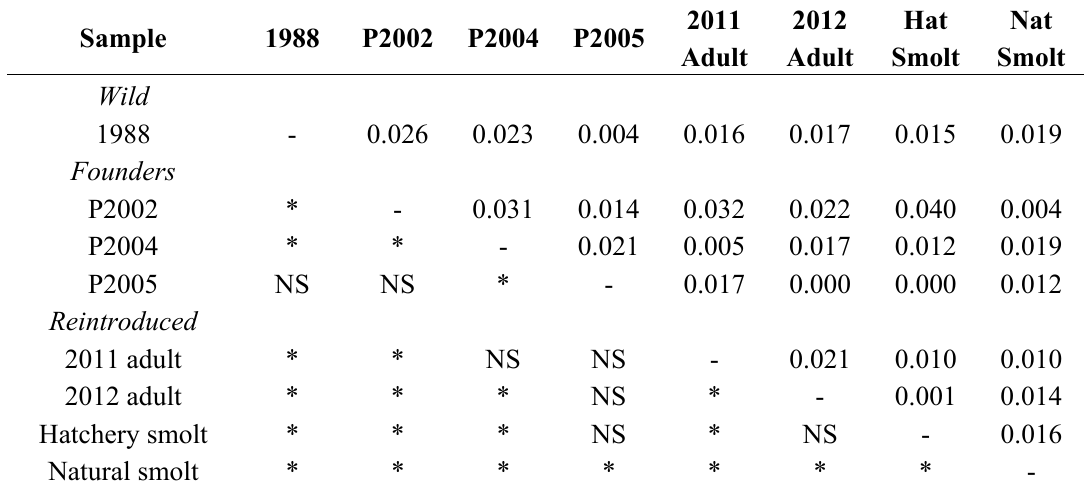
Table 5. Pairwise F values between wild and reintroduced Sakinaw sockeye salmon are ST given above the diagonal. Wild founders of the captive breeding program were represented genotypes (P2004). Reintroduced fish by parental genotypes (P2002 and P2005) or F 2 included both adult and smolts; smolts originated from spawning at Rosewall hatchery (Hat) or in Sakinaw Lake (Nat). Significant (asterisk) and non-significant (NS) allele frequency differentiation is indicated below the diagonal.